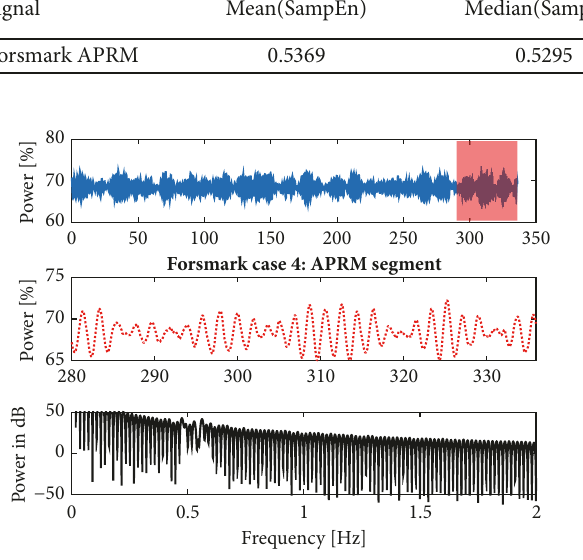
Figure 18: Studied segment of the Forsmark Case 4 APRM.